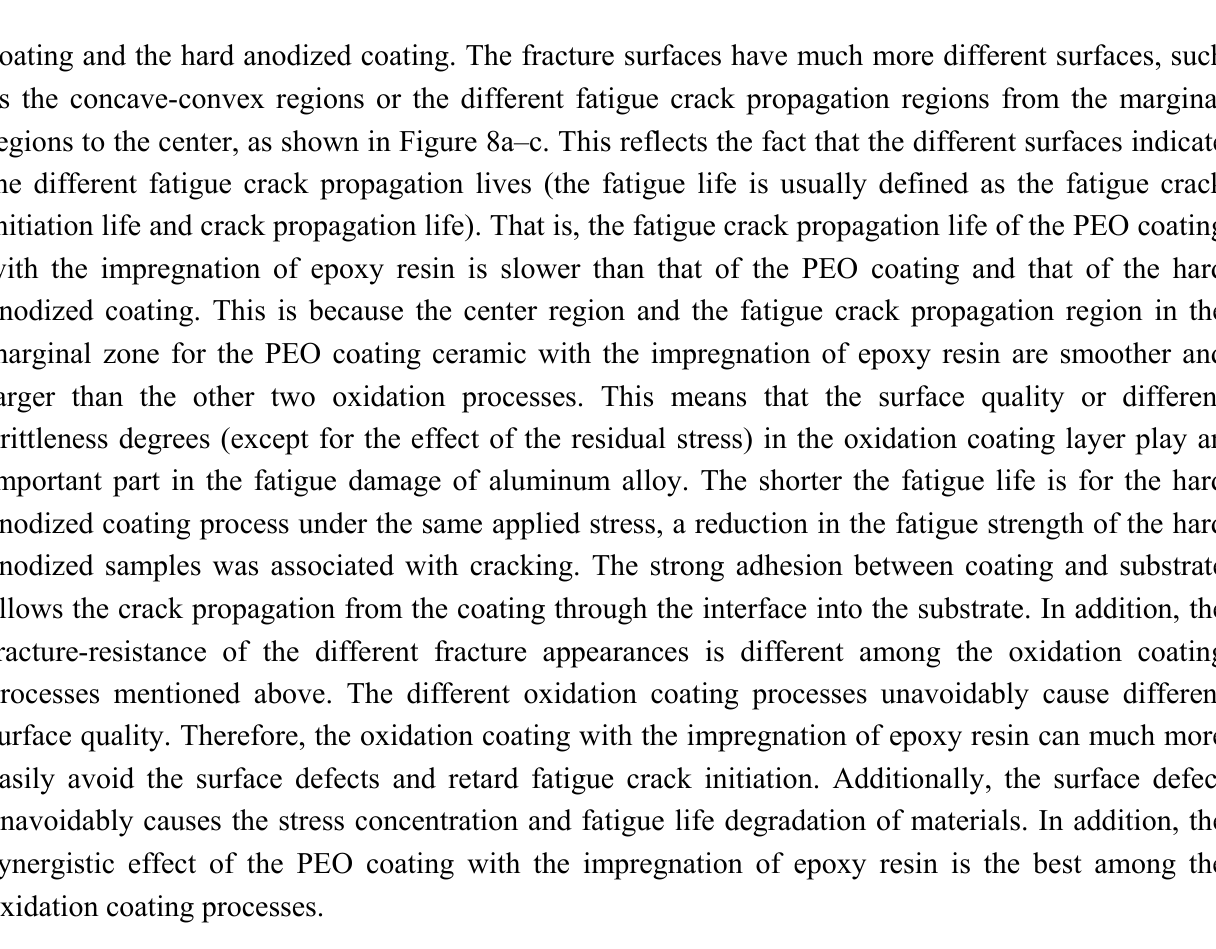
Figure 8. Fatigue fracture morphology for different oxide processes of 2024-T4 Al